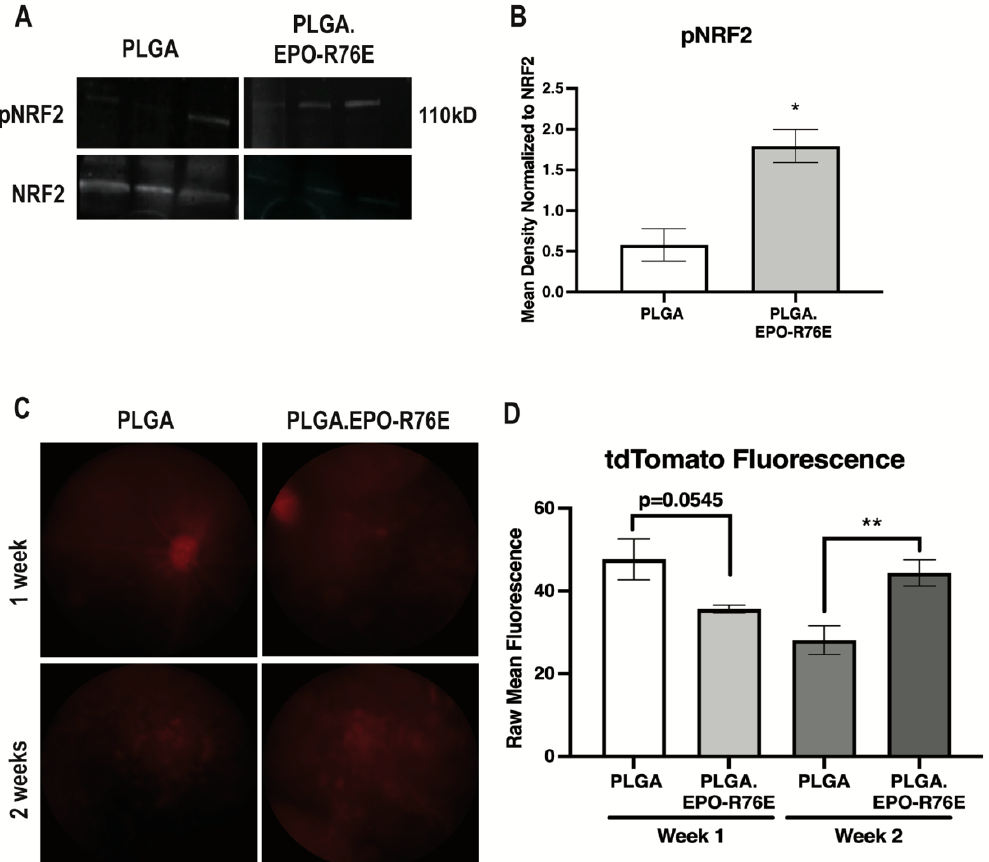
Figure 3. ( A ) Representative Western blot for pNRF2 and NRF2 in PLGA and PLGA.EPO-R76E injected mice at 2 weeks post-IOP elevation. ( B ) Quantification of pNRF2 levels normalized to total NRF2 levels at 1 week post-IOP elevation, * p < 0.05. ( C ) Representative fundus images of mice injected with AAV2/2.ARE 2 weeks prior to IOP elevation, imaged at both 1 and 2 weeks post-IOP elevation in mice treated with PLGA or PLGA.EPO-R76E. ( D ) Quantification of tdTomato fluorescence in mice injected with AAV2/2.ARE at 1 and 2 weeks post-IOP elevation, ** p = 0.01.